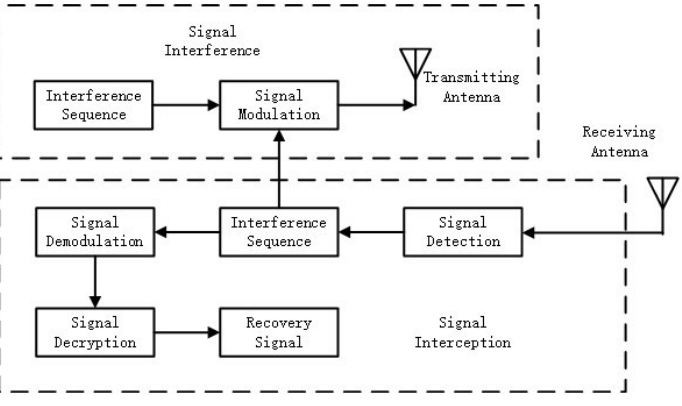
Figure 1. Military application of